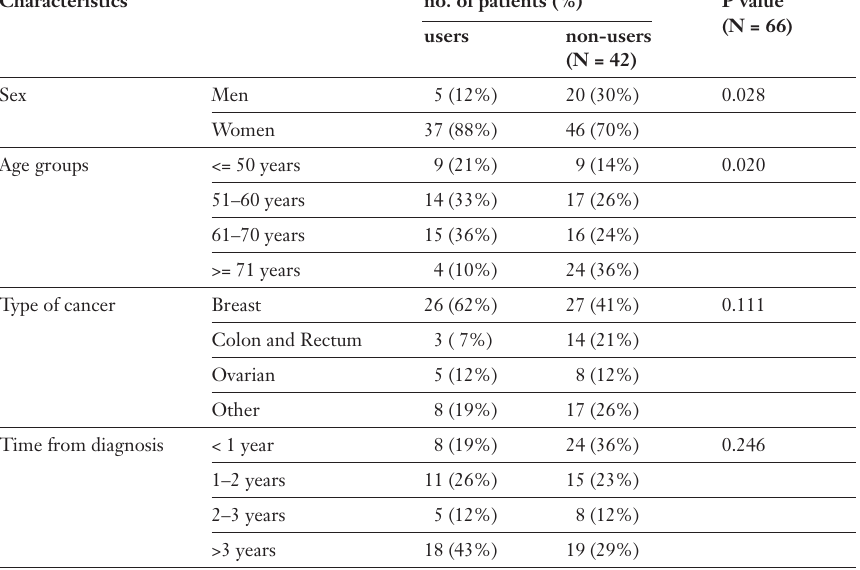
users: users of alternative cancer treatment non-users: non-users of alternative cancer treatment